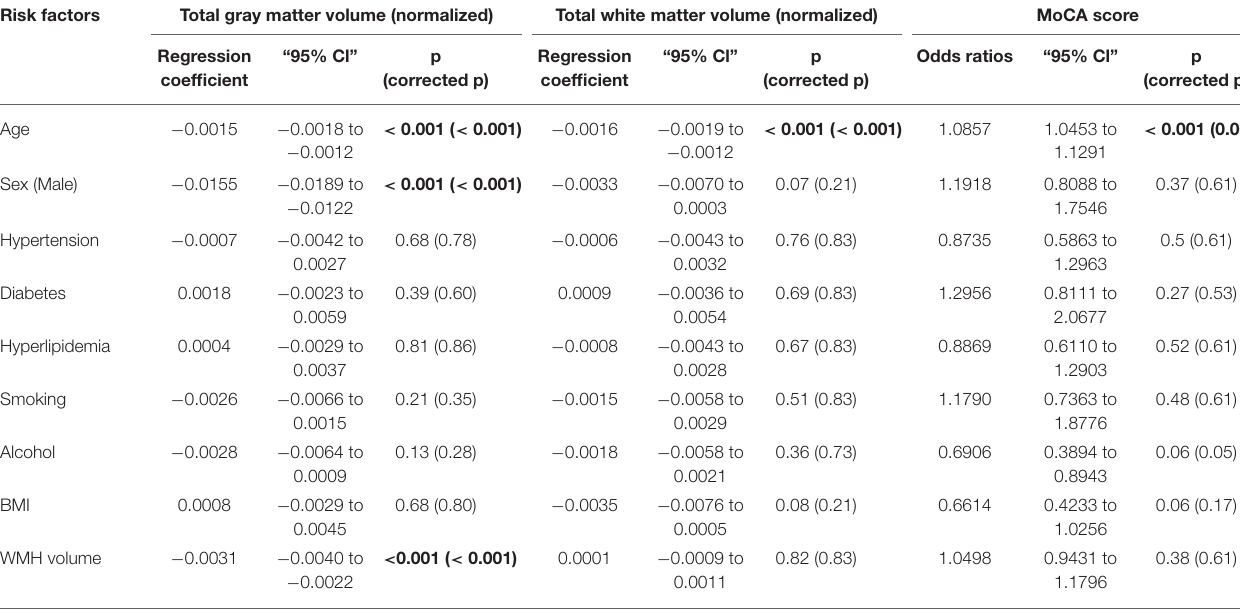
TABLE 3 | Associations between multiple risk factors and the volumes of the gray and white matter as well as MoCA scores. Risk factors Total gray matter volume (normalized) Total white matter volume (normalized) MoCA score Regression “95% Cl” p Regression “95% Cl” p Odds ratios “95% Cl” p coefficient (corrected p) coefficient (corrected p)